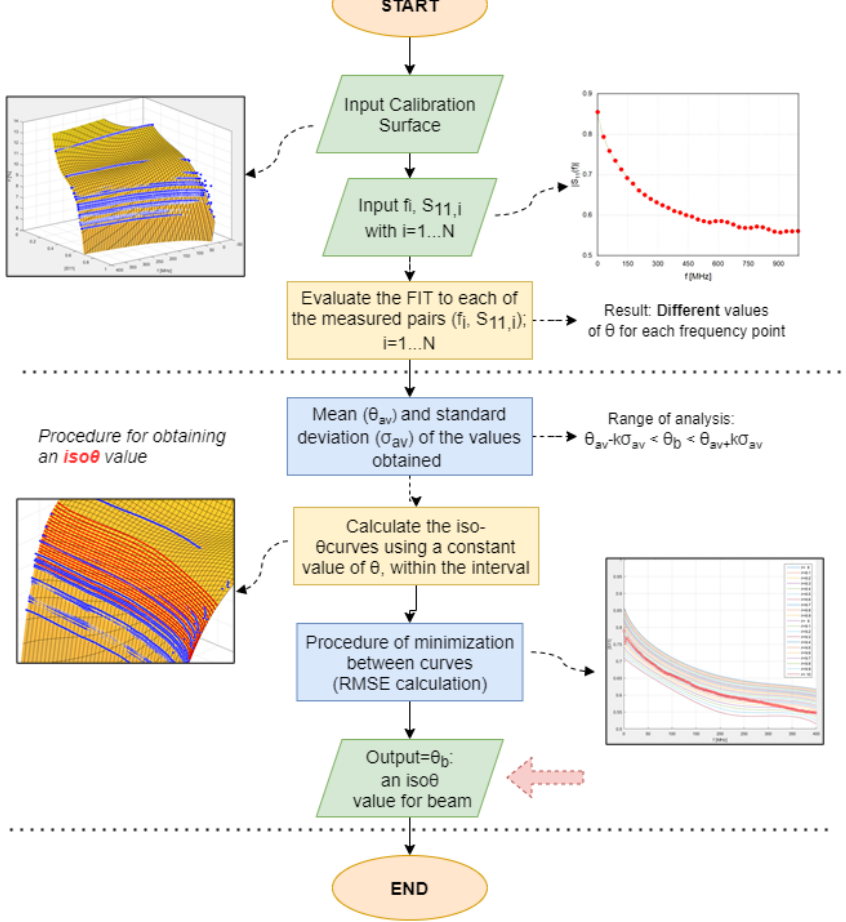
Figure 9. Flowchart of MATLAB algorithm developed to extrapolate the volumetric water content of the beam using the calibration